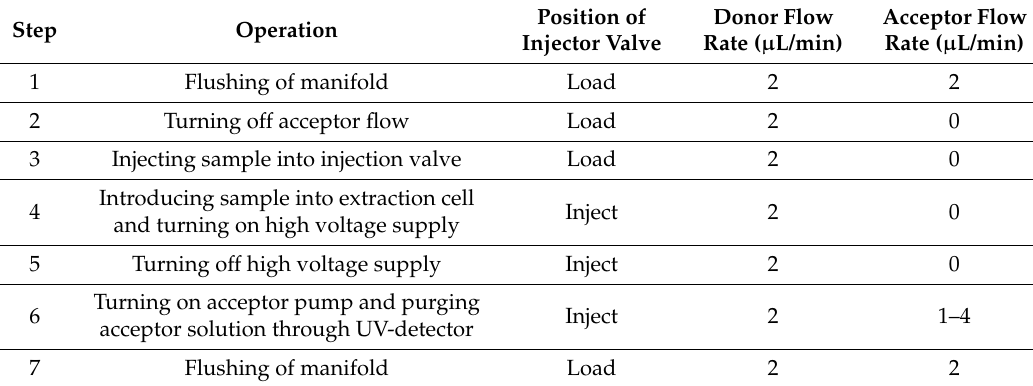
Table 1. Typical operating sequence.